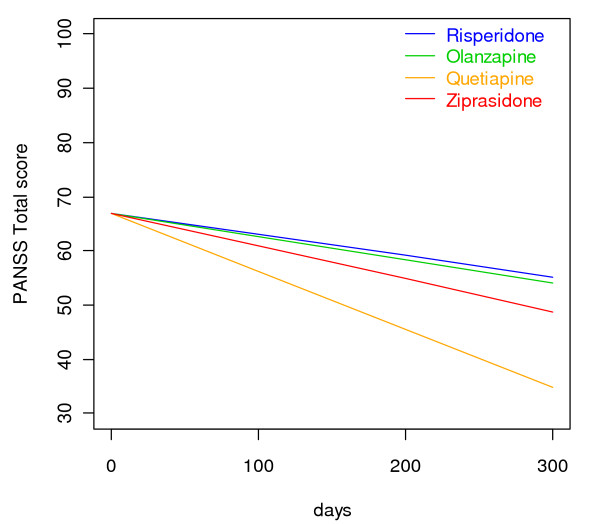
Reduction of PANSS total score. Linear mixed effects model curves. Linear slopes for the randomization groups generated based on linear mixed effects models PANSS total score output as displayed in Additional file 2 for risperidone, olanzapine, quetiapine, and ziprasidone, respectively. The curves are confined to the first 300 days because the major bulk of data is obtained before 300 days.